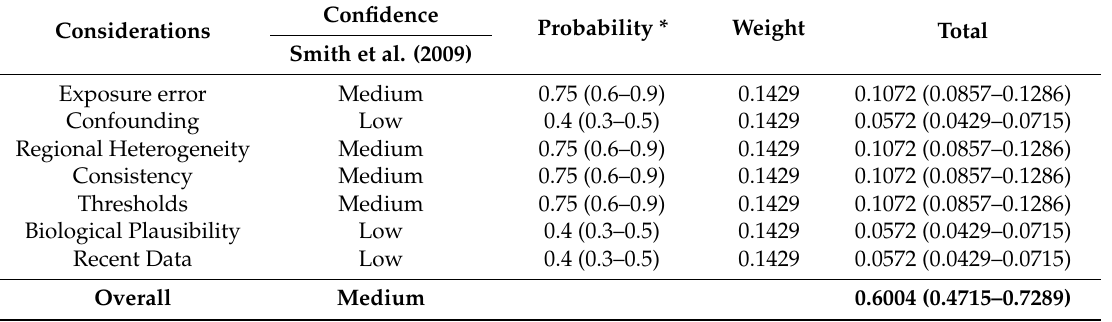
Table 2. Example of Probably Weights Applied to Seven Confidence Areas of Smith et al. (2009), Based on Confidence